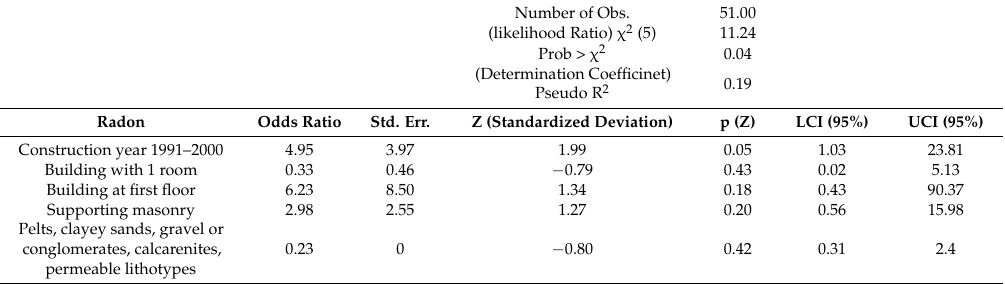
Table 2. Adjusted risk (ORs) to observe Radon concentrations above the 75th percentile (145 Bq/m 3 ). Number of